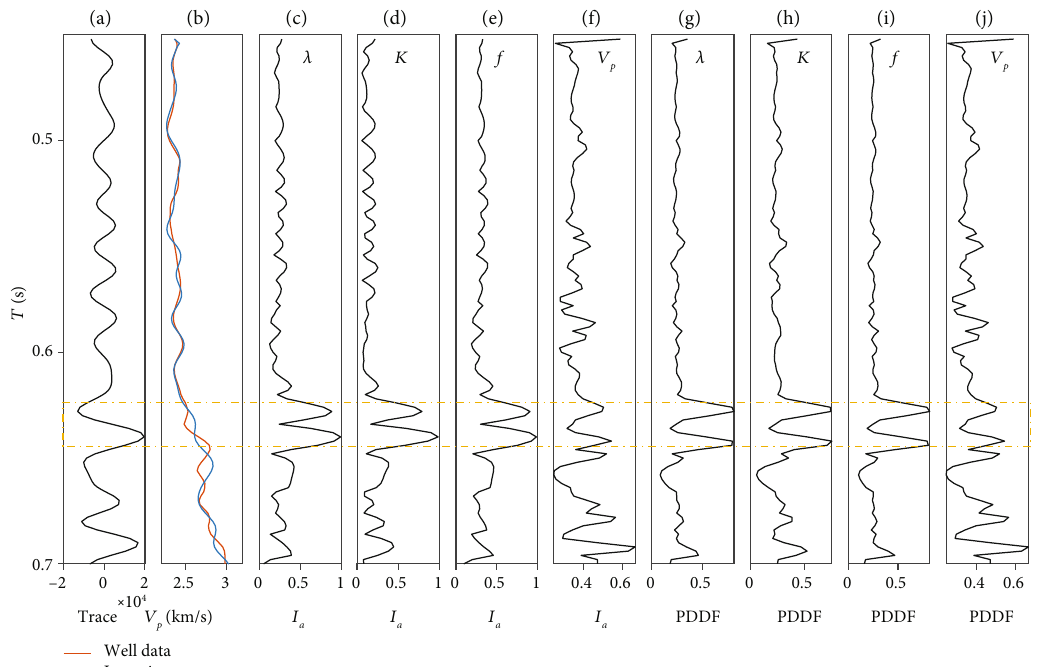
Figure 12: Display of various parameters at the well location. (a) is the poststack seismic trace; (b) is the P-wave velocity, the red curve is the real well log after smoothing, and the blue curve is the inverted result; (c) is the dispersion term of Lamé parameter ( λ ); (d) is the dispersion term of bulk modulus ( K ); (e) is the dispersion term of Russell fl uid factor ( f ) ( γ 2 dry = 2 : 3 ); (f) is the dispersion term of P-wave velocity ( V P ); (g) is the PDDF of Lamé parameter ( λ ); (h) is the PDDF of bulk modulus ( K ); (i) is the PDDF of Russell fl uid factor ( f ) ( γ 2 dry = 2 : 3 ); (j) is the PDDF of P-wave velocity ( V P ). The yellow dotted rectangle highlights the location of the gas